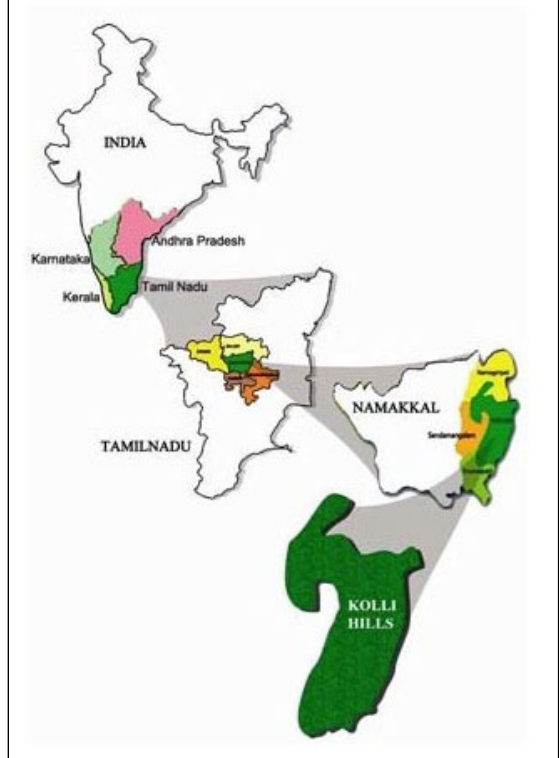
Figure 1. Map Showing the Location of the Kolli